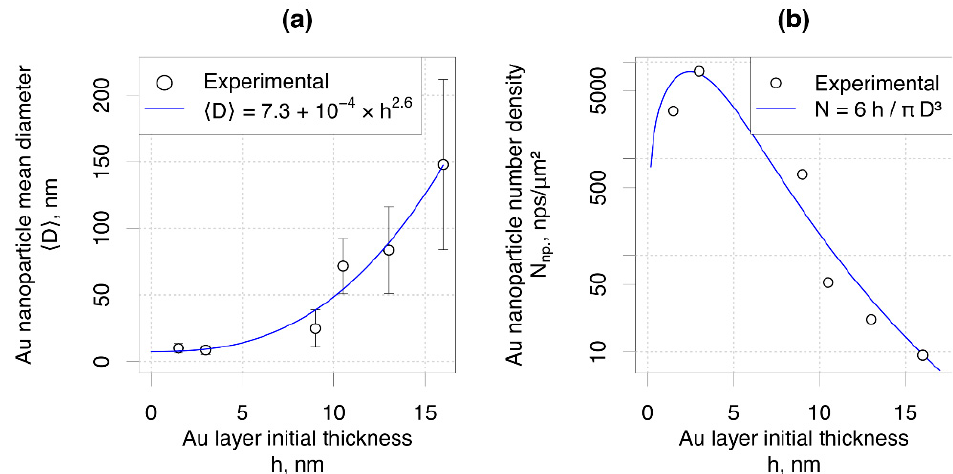
Figure 2. ( a ) Mean Au nanoparticle diameter, the blue line is a fitted power function; ( b ) Au nanoparticle number density (the blue line is the expected number density).